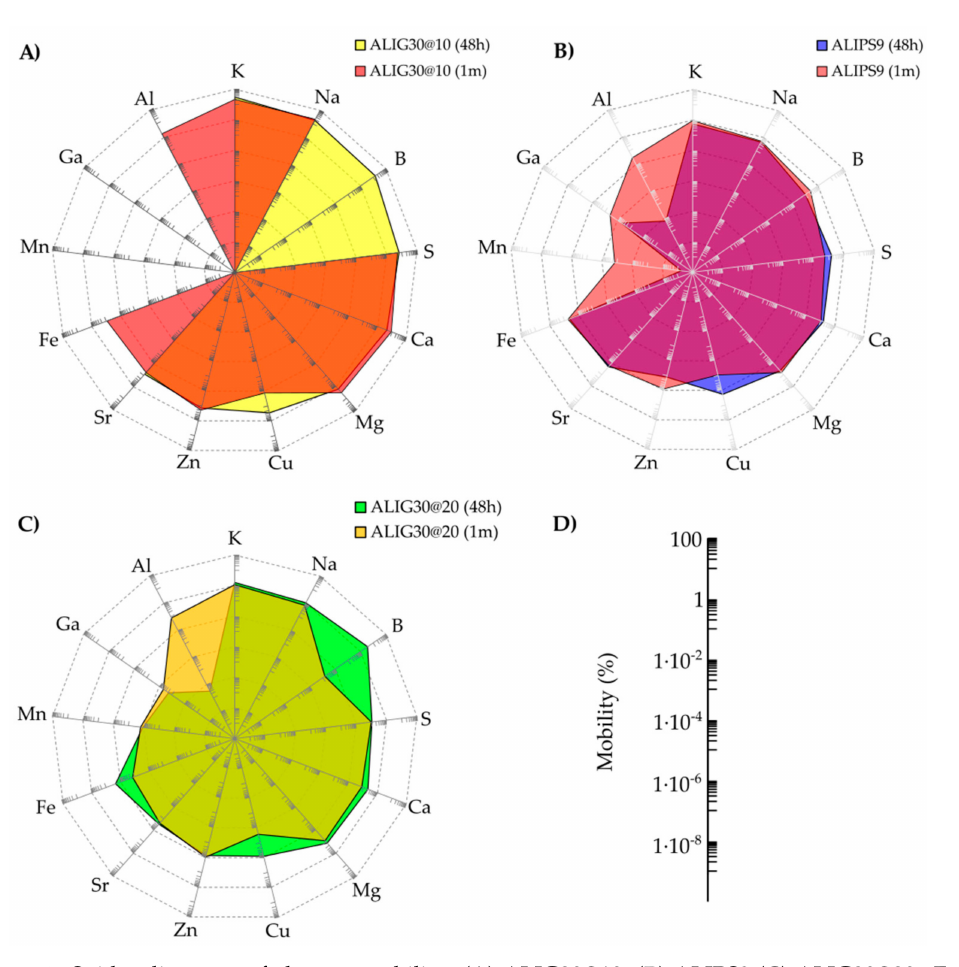
Figure 4. Spider diagrams of element mobility. ( A ) ALIG30@10; ( B ) ALIPS9 ( C ) ALIG30@20. For simplicity, the scale of the diagrams has been represented independently in ( D